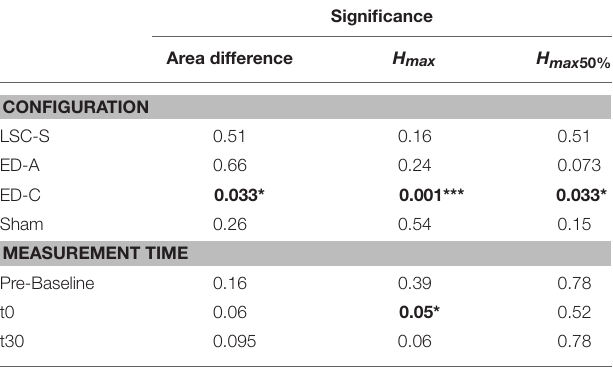
Spinal Cord—Shoulder), which had been shown to induce a significant left shift of the H-reflex recruitment curve (Lamy et al.,